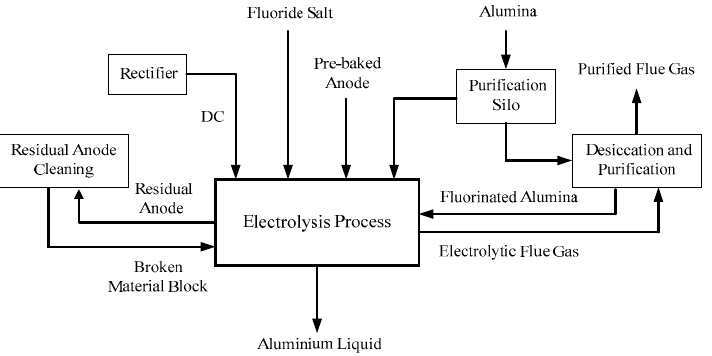
Figure 2. The internal structure of the aluminum electrolytic cell. Figure 3. The process flow diagram of the aluminum electrolysis process.